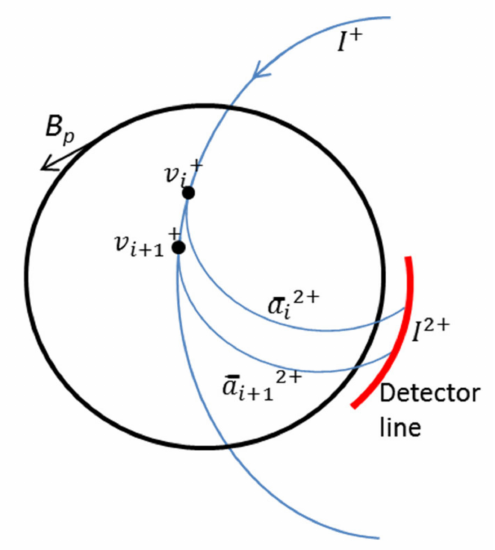
Figure 17. Trajectories of two consecutive secondary beams generated at two very close ionization